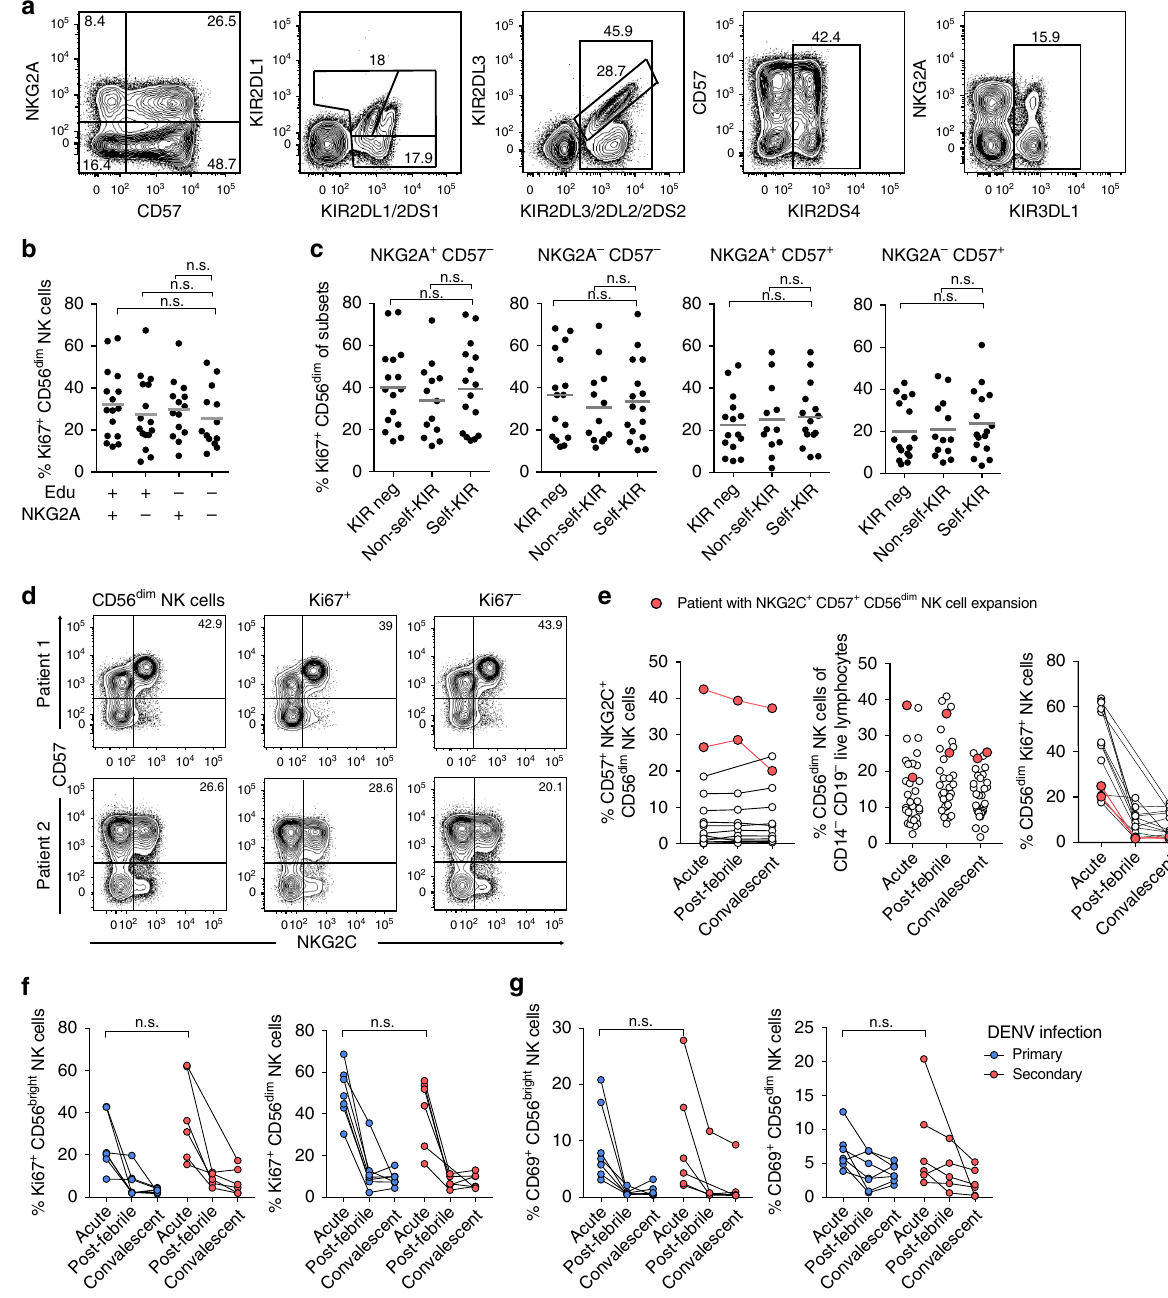
Fig. 3 CD56 dim natural killer (NK) cell responses during acute dengue virus (DENV) infection are uncoupled from NK cell education. a Gating strategy